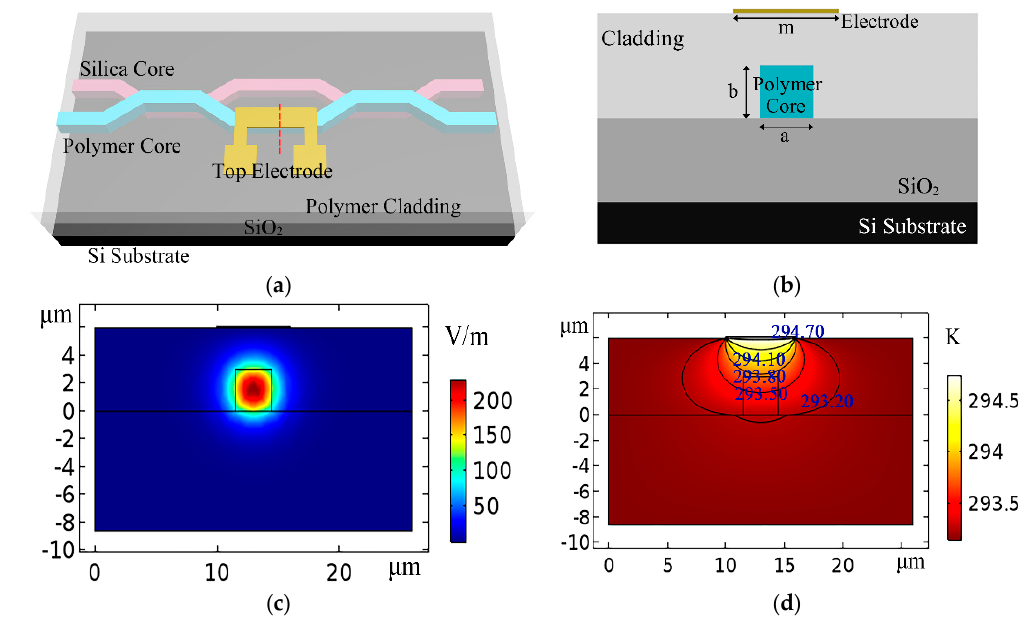
Figure 2. TO switch with top electrode structure by a lithography process. ( a ) Three-dimensional structure; ( b ) two-dimensional cross-sectional structure in the heating region (the position of the red dotted line in Figure 2a); ( c ) optical field distribution in the heating region; ( d ) thermal field distribution in the heating region.